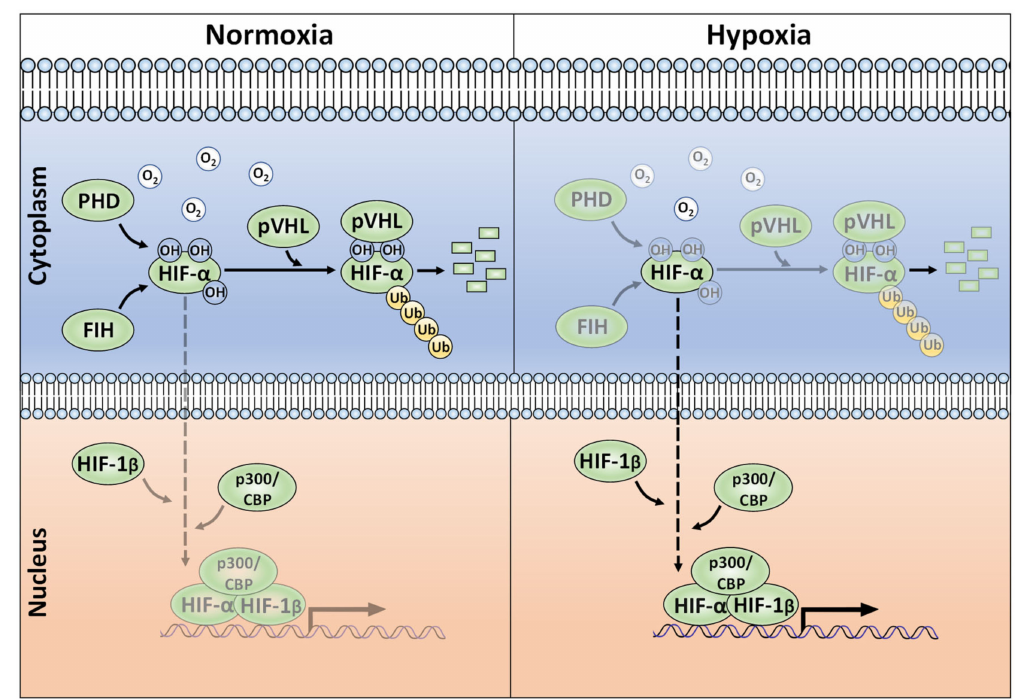
Figure 1. The canonical oxygen-dependent degradation mechanism for HIF- α by pVHL-mediated 26S proteasomal degradation and its inhibition by Factor-Inhibiting HIF (FIH) during